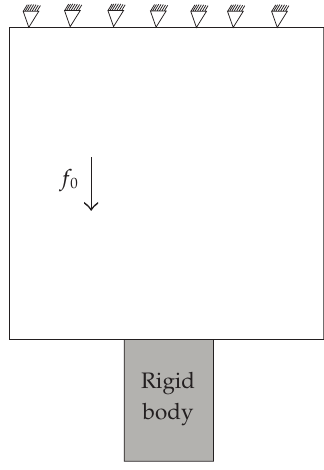
Figure 4.5 . Contact problem of a 2D viscoplastic body.